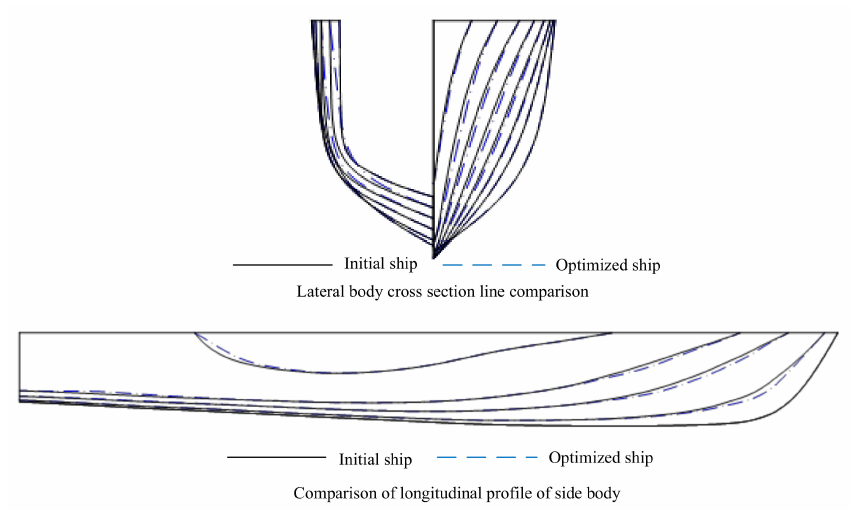
Figure 14. Comparison of side body lines.